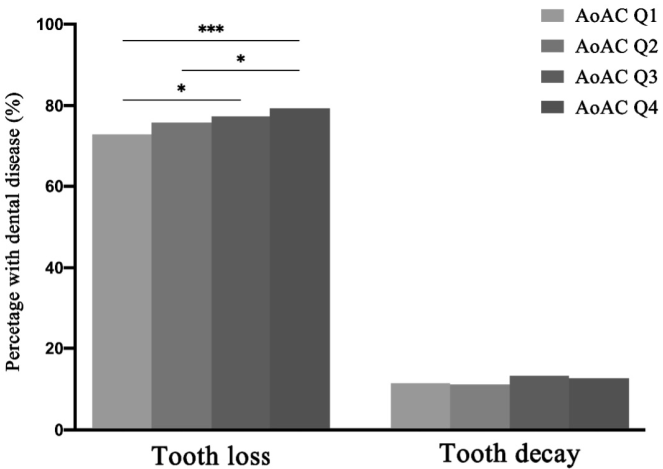
Figure 2. The proportion of participants with tooth loss or tooth decay in each group divided with quartiles of AoAC scores. * Bonferroni-adjusted p < 0.05, *** Bonferroni-adjusted p < 0.001.